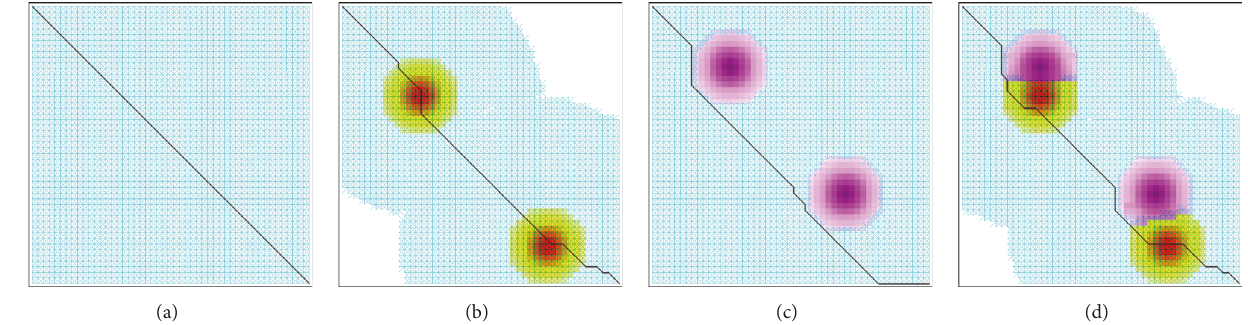
Figure 3: Finding a path (in black) from the top-left node to the bottom-right node of a 50 × 50 grid using our influence-aware Dijkstra’s (DjT) pathfinder: (a) without attractors and repulsors, the search space (neutral nodes in cyan) covers the entire map; (b) with 2 attractors, the search space does not cover the entire map, but it counts on neutral nodes (in cyan) and attractor nodes (in red-to-yellow blended with cyan); (c) with 2 repulsors, the search space covers neutral nodes (in cyan) but not repulsor nodes (in dark lilac-to-light lilac); (d) with 2 attractors and 2 repulsors, the search space partially covers neutral nodes (in cyan) and attractor nodes (in red-to-yellow blended with cyan). Nodes in cyan or blended with cyan represent visited nodes, that is, nodes in the open and closed lists.